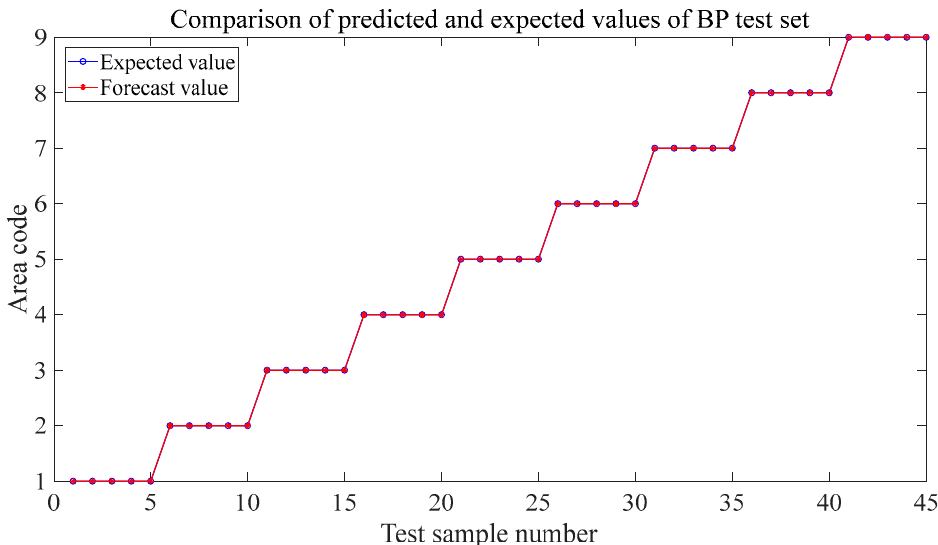
Figure 11. Prediction results when the excitation point of the test set is within 10 mm of the center.